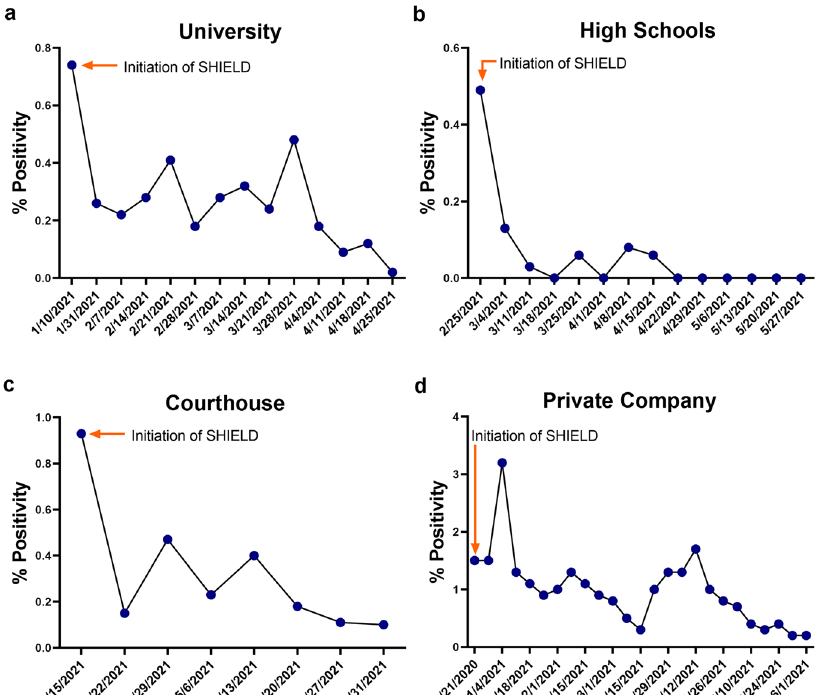
Fig. 6 Other communities with SHIELD. SHIELD was deployed at other locations in Winter 2020/Spring 2021. The results from four representative examples are shown: a a university (1×/week), b a pair of high schools (2×/week), c a courthouse (2×/week), and d a large private corporate campus